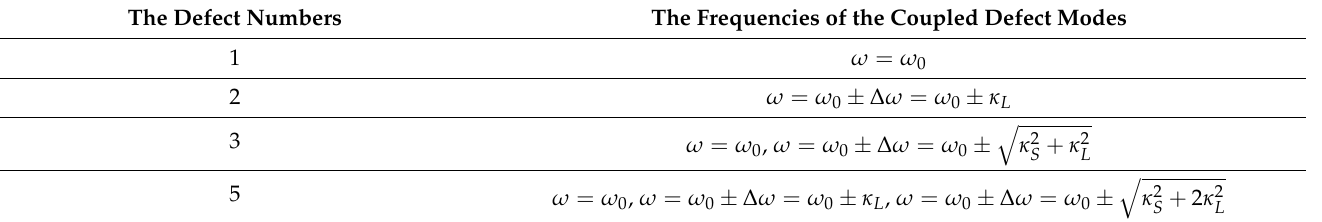
Table 1. The frequencies of the coupled defect mode for N = 1, 2, 3, 5, respectively. The Defect Numbers The Frequencies of the Coupled Defect